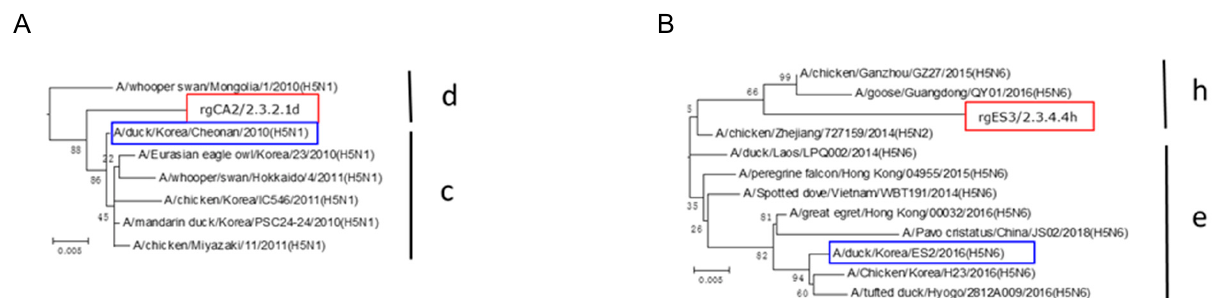
Figure 1. Phylogenetic trees of clades 2.3.2.1 and 2.3.4.4 (HA; H5). The vaccine strains developed by reverse genetics are indicated in red. Each tree was built using the distance-based neighbor-joining method in MEGA6 software (bootstrap value = 1000). Red boxes indicate challenge strain and blue boxes indicate vaccine strain. ( A ) rgCA2/2.3.2.1d. ( B ) rgES3/2.3.4.4h.